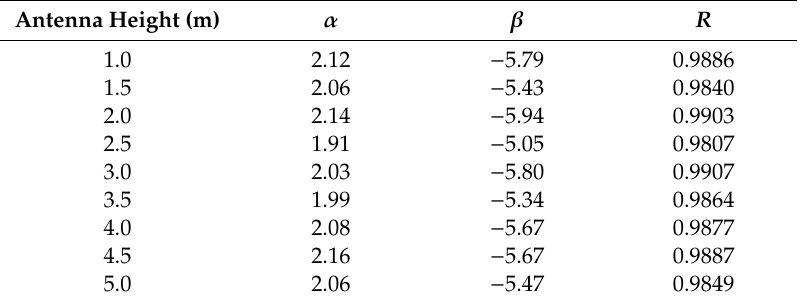
Figure 2. The root mean square (RMS) of the peak frequency estimation error as a function of peak power spectral density (PSD). Table 1. Fitting parameters and correlation coefficients for different antenna heights.